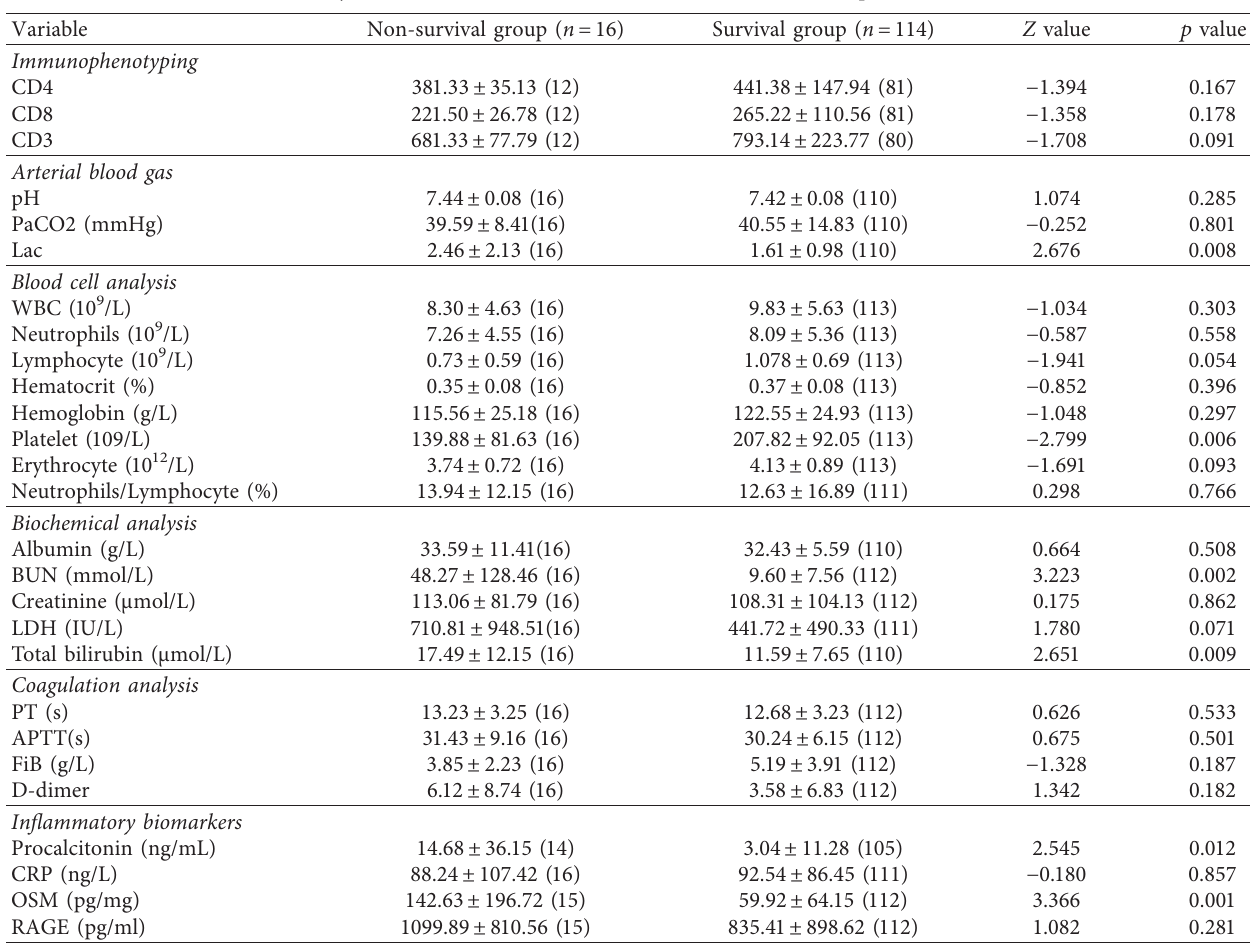
Table 6: Laboratory examination results between survival and nonsurvival patients before